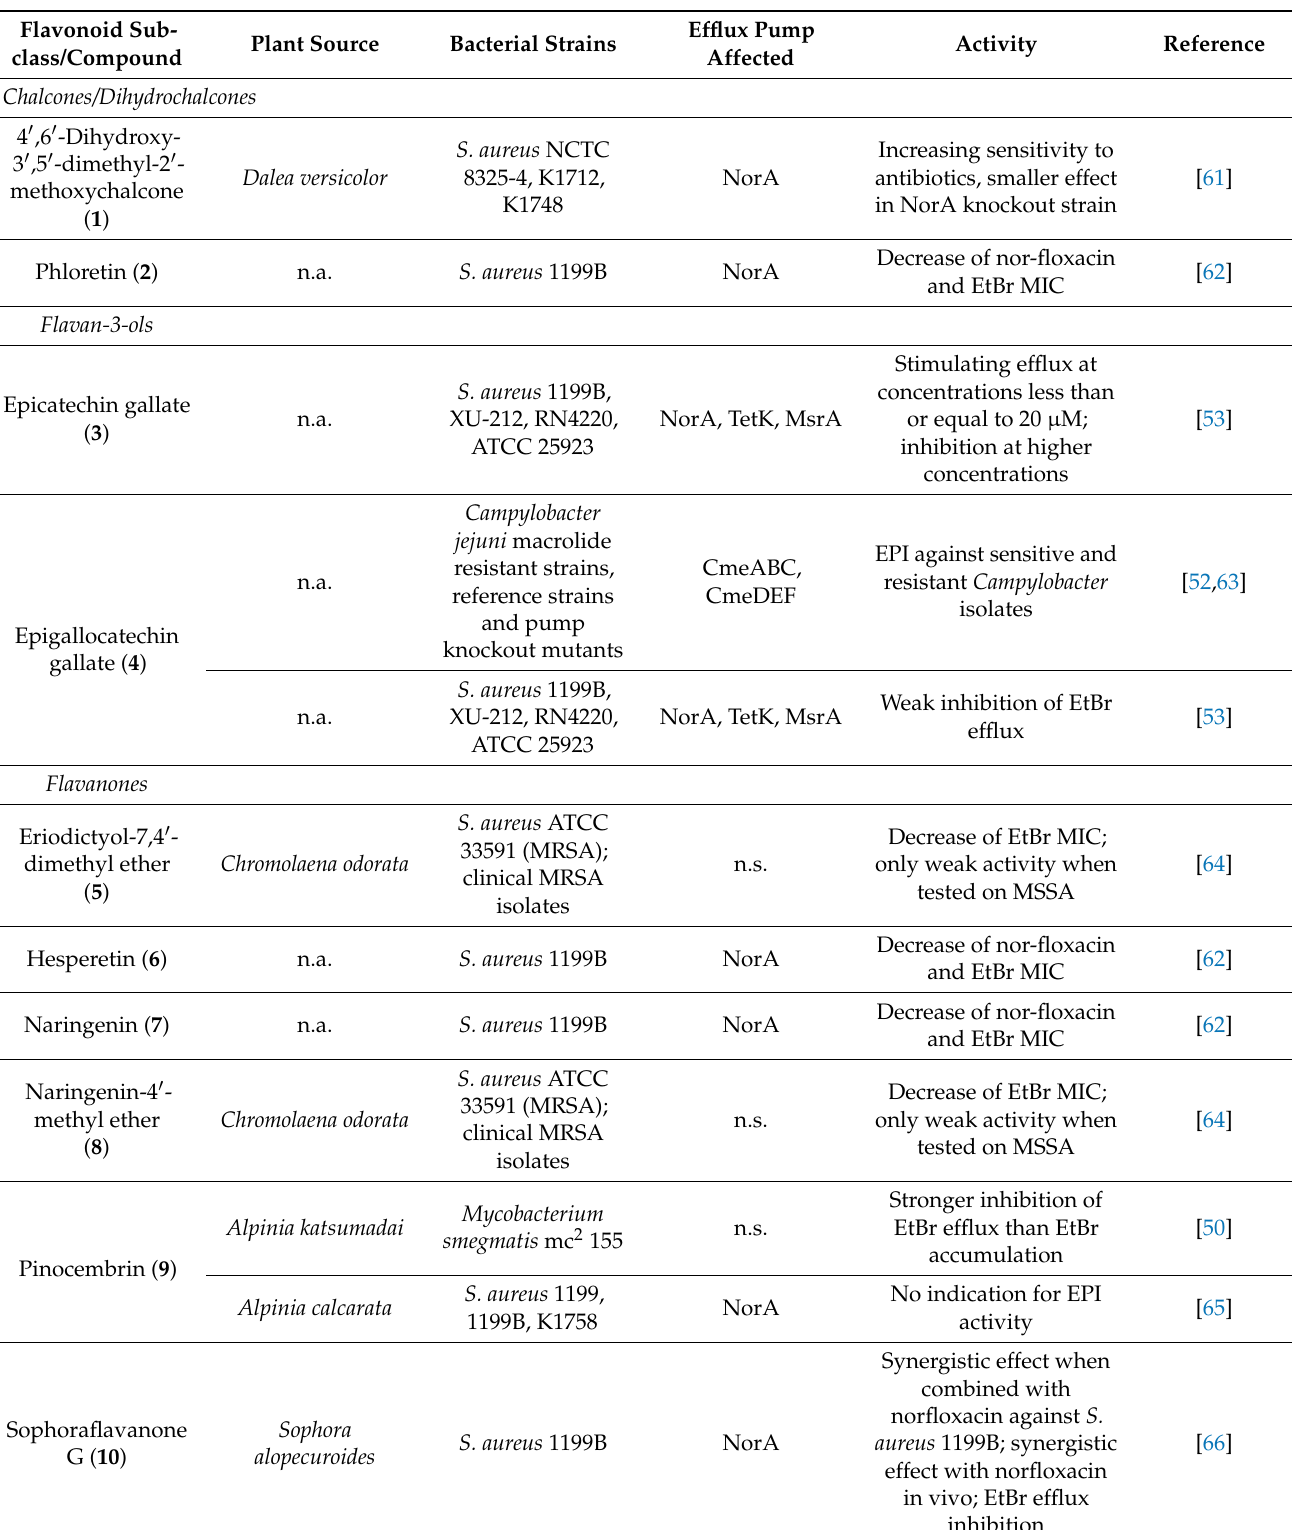
Table 1. Naturally occurring flavonoids with reported efflux inhibiting effects in